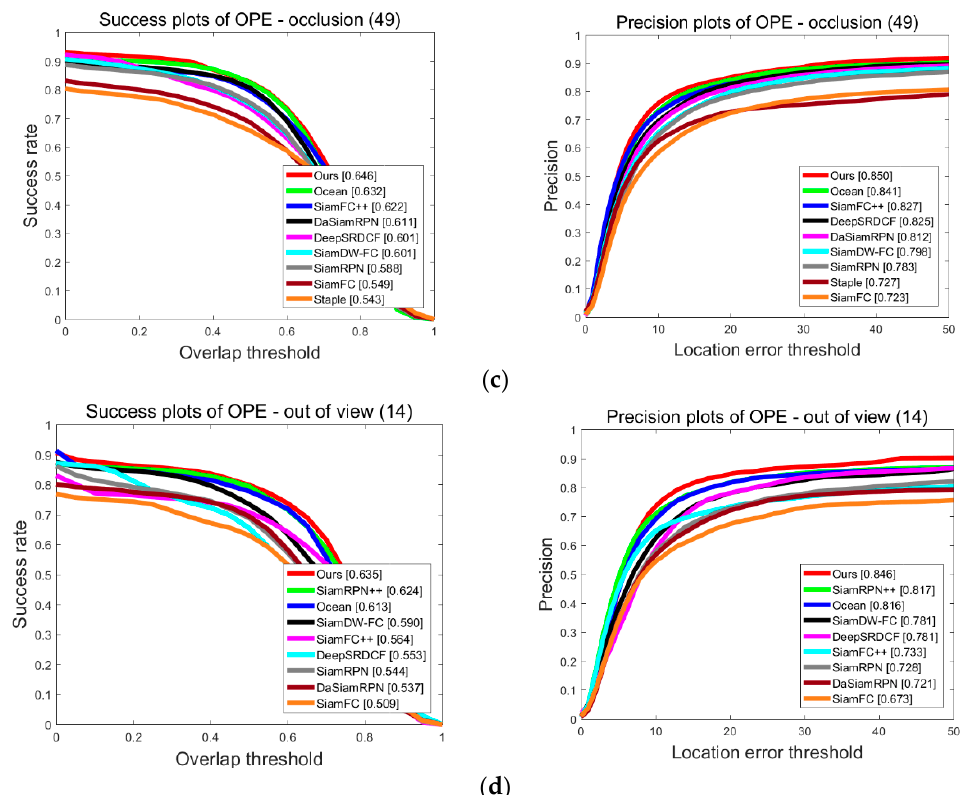
Figure 12. Experimental results corresponding to 4 typical scenarios on OTB100, including ( a ) fast motion; ( b ) motion blur; ( c ) occlusion; ( d ) out of view.